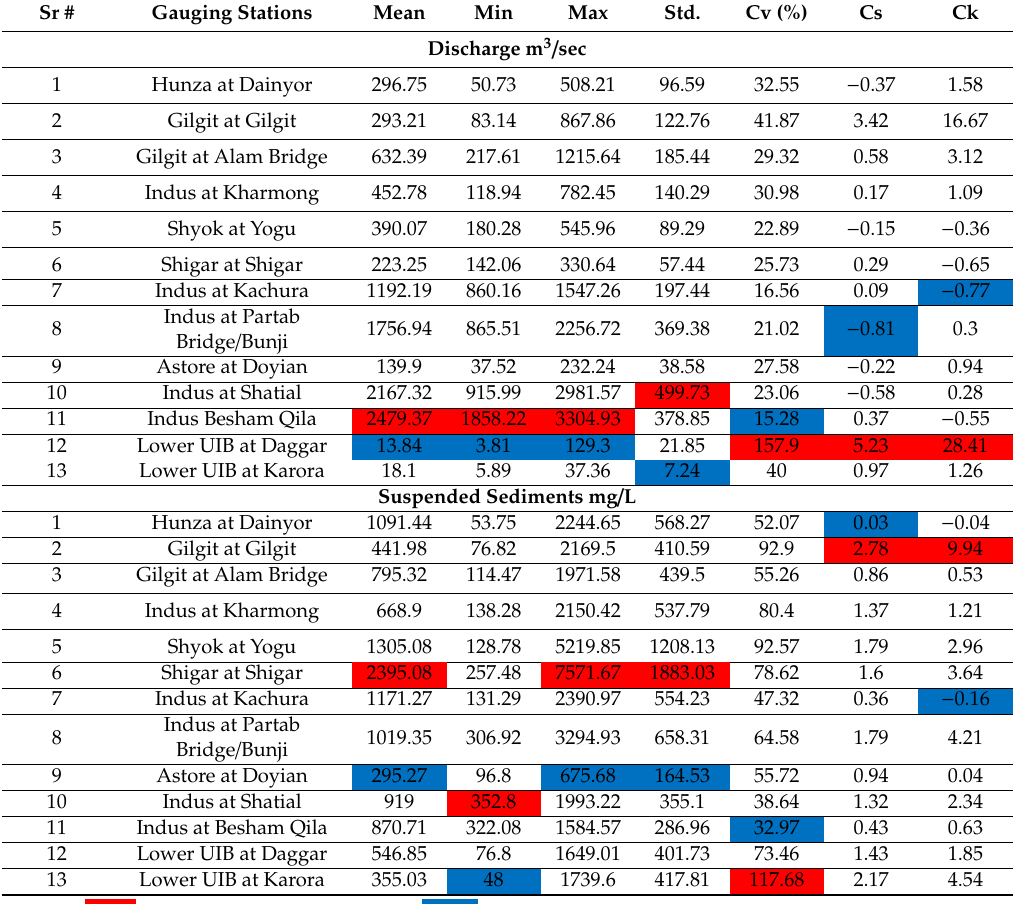
Table 5. Summary of descriptive statistics of the selected discharge and sediment gauging